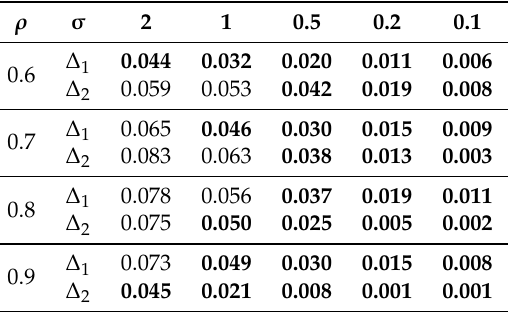
Table 1. Values of Kolmogorov distances ∆ k of approximations ˆ R k ( n ) from Equation (54) for various values of σ and ρ